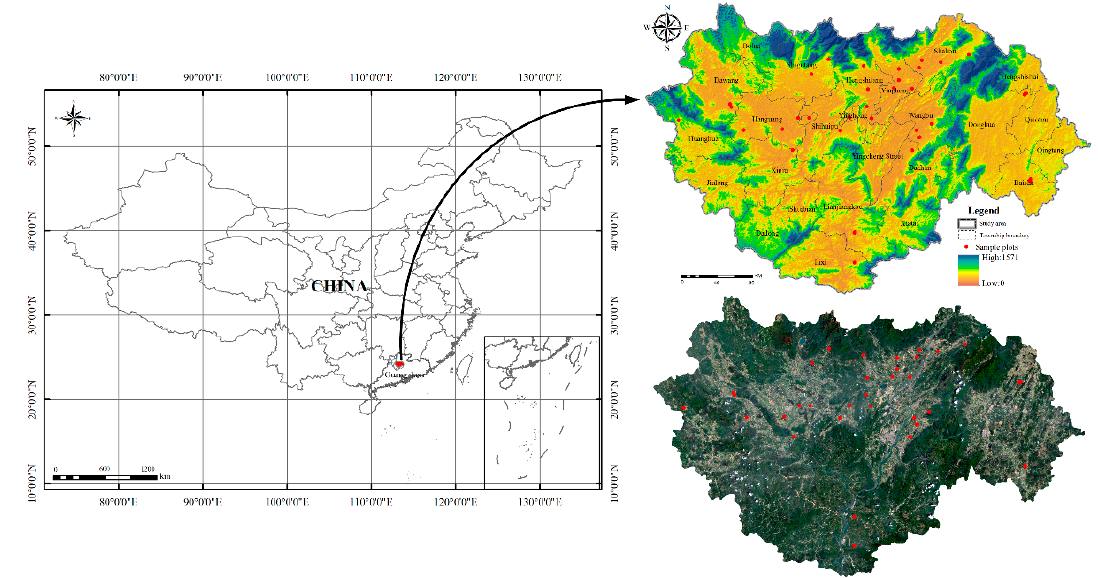
Figure 1. Location of the study area.